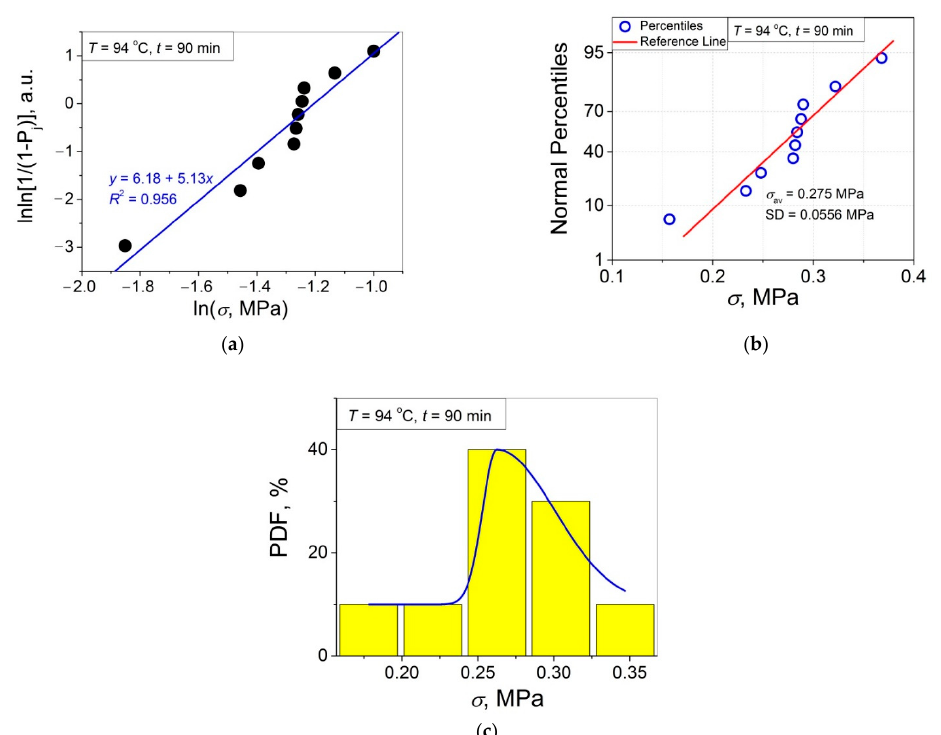
Figure 4. ( a ) Linear regression fit of the lap shear strength σ in Weibull’s coordinates; ( b ) normal probability plot; ( c ) probability density function (PDF) vs. σ fitted with a bi-Gaussian function for an amorphous PET–PET interface self-bonded at T = 94 °C for t = 90 min.